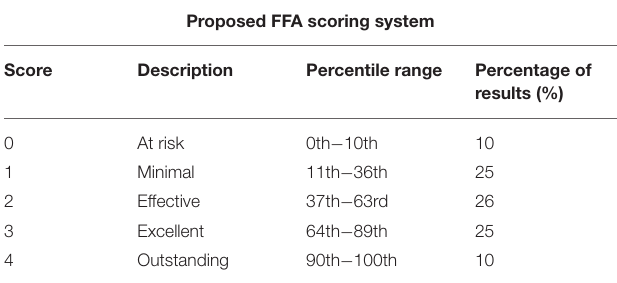
TABLE 4 | Proposed Foundational Fitness Assessment scoring